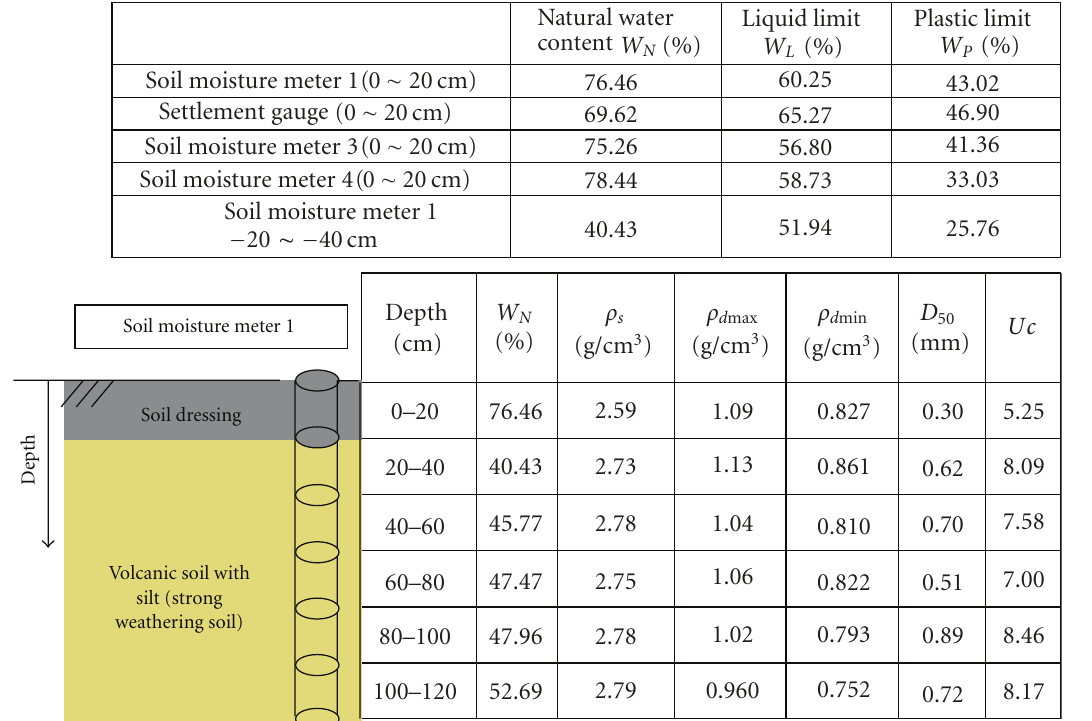
Figure 5: Index properties of soil